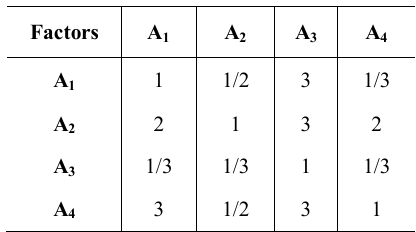
Table 2: Pairwise Comparison Matrix with respect to Eco- environment Vulnerability